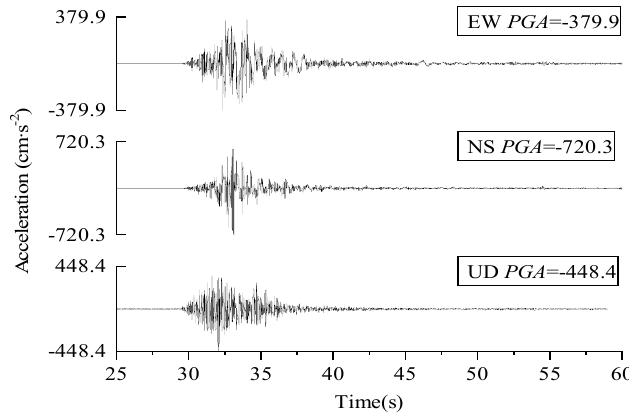
Figure 1. Acceleration time − history of Yangbi ground motion.